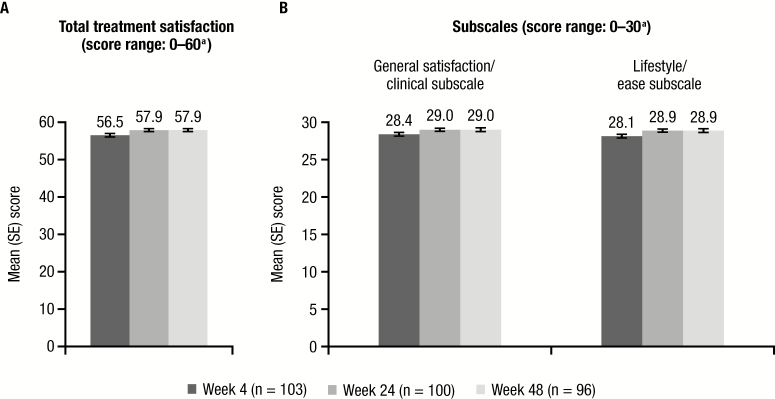
Human Immunodeficiency Virus Treatment Satisfaction Questionnaire status version (HIVTSQs) scores at weeks 4, 24, and 48 after rapid initiation of darunavir/cobicistat/emtricitabine/tenofovir alafenamide. A, Total HIVTSQs scores. B, HIVTSQs subscale scores. aHigher scores indicate greater satisfaction. Abbreviation: SE, standard error.